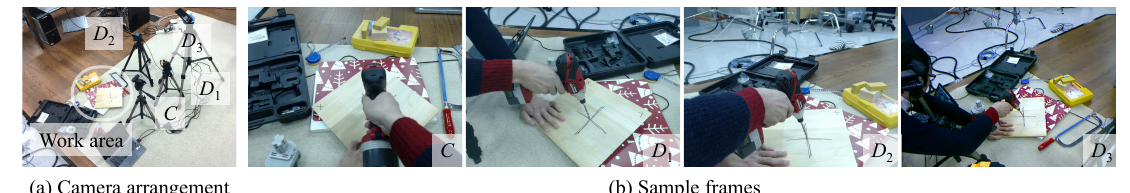
Figure 3. Setup of the video performance evaluation.